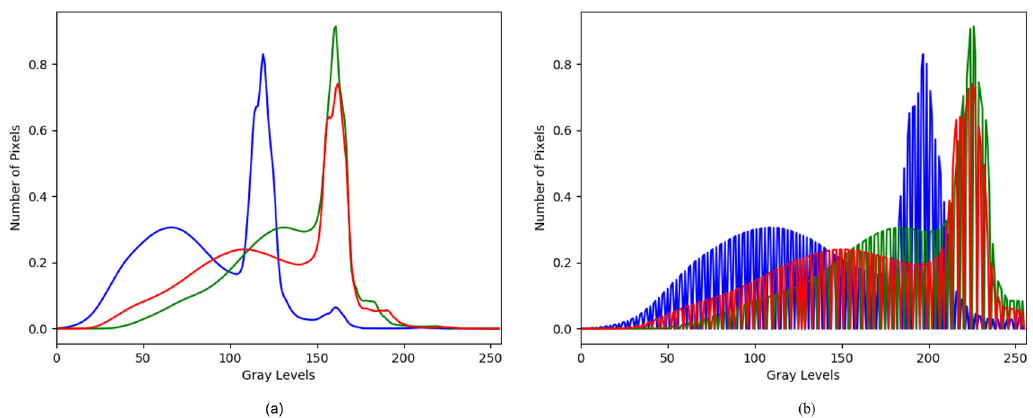
Fig 3. RGB color histogram. (a) Color histogram of orthomosaic (b) Color histogram of orthomosaic after LCS.